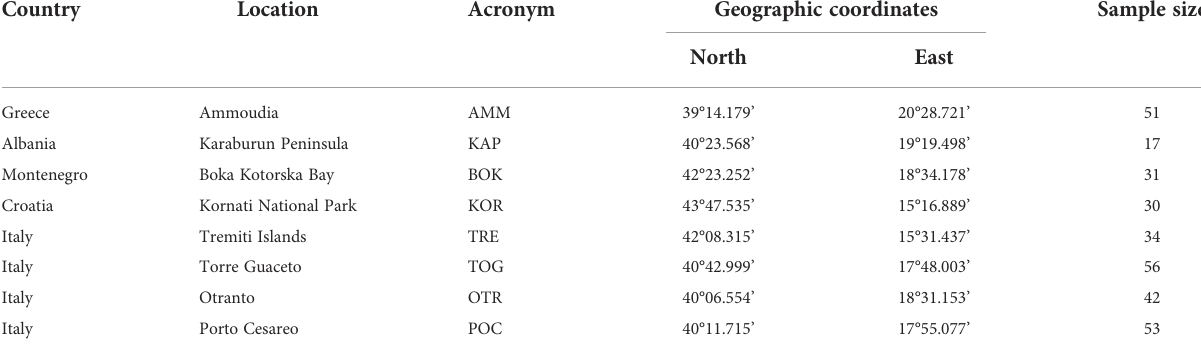
TABLE 1 Summary of samples analysed in this study. Country